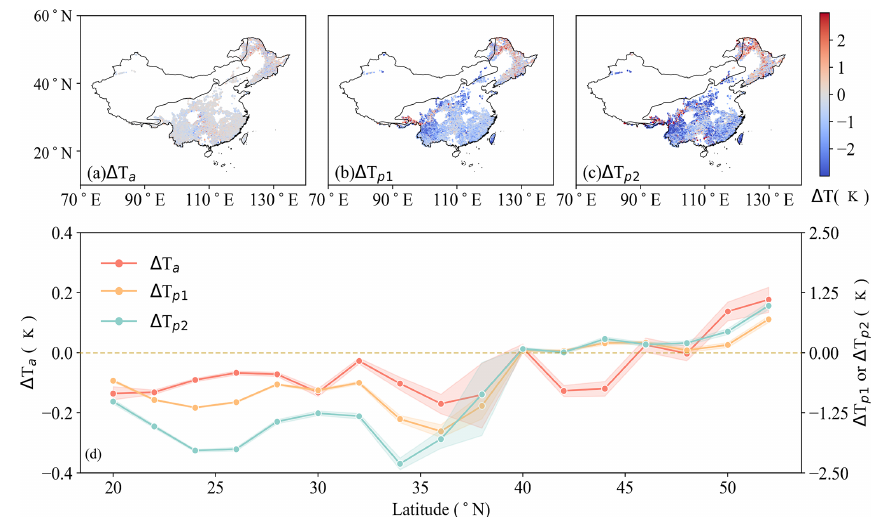
Figure 4. Afforestation effects on LST quantified by three approaches: (a) actual effect based on a space-and-time approach ( (cid:49)T a ), (b) mixed potential effect based on a space-for-time approach ( (cid:49)T p to 100% forest coverage using the SVD method ( (cid:49)T p averages of the annual mean daytime LST change within 2 ◦ latitudinal bins, with shaded areas representing the standard errors (SE). Note that in (d) , (cid:49)T a corresponds to the vertical axis on the left; (cid:49)T p